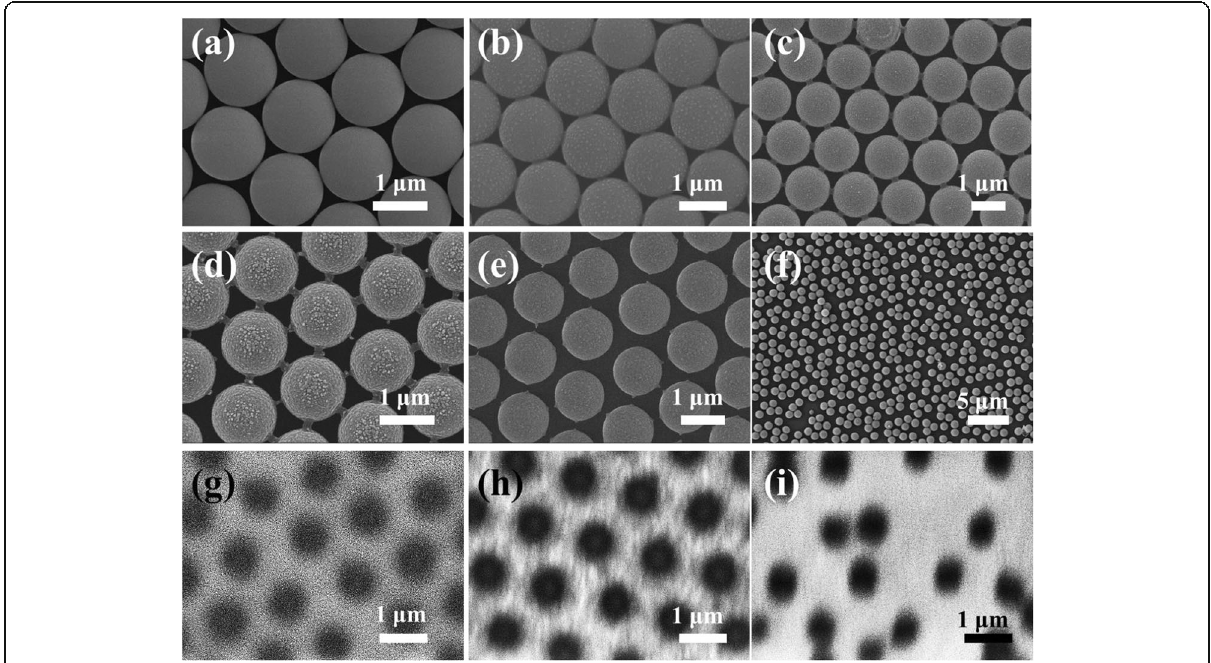
Fig. 3 PS microspheres templates etched for 0 min ( a ), 5 min ( b ), 10 min ( c ), 15 min ( d ), 20 min ( e ), and 30 min ( f ). Displacement was observed for PS microspheres etched for 30 min, resulting in a disorder PS array. g – i The corresponding cross-linked networks after removing the PS